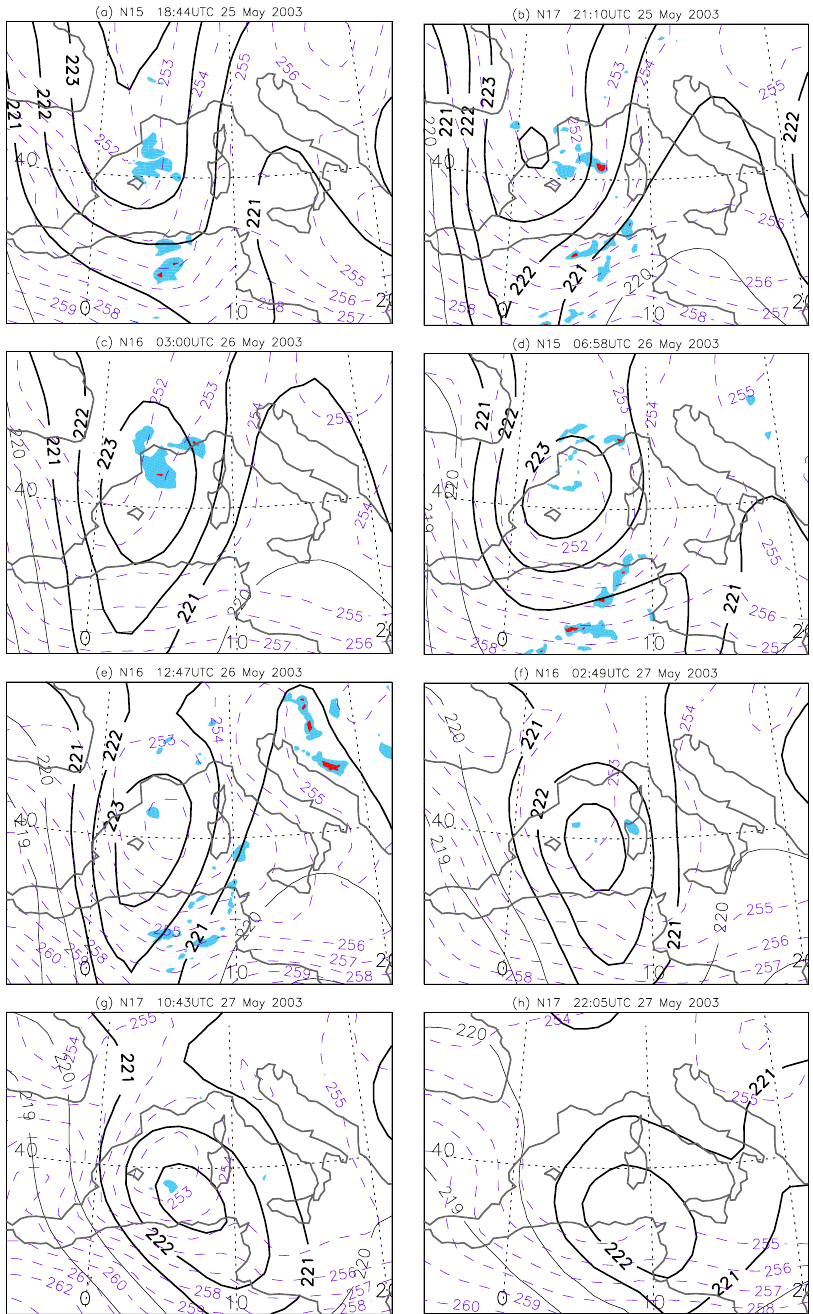
Figure 11 Figure 11 Fig. 11. Same as Fig. 7, but for: (a) NOAA-15, 25 May 2003, 18:44UTC, (b) NOAA-17, 25 May 2003, 21:10UTC, (c) NOAA-16, 26 May 2003, 03:00UTC, (d) NOAA-15, 26 May 2003, 06:58UTC, (e) NOAA-16, 26 May 2003, 12:47UTC, (f) NOAA-16, 27 May 2003, 02:49UTC, (g) NOAA-17, 27 May 2003, 10:43UTC, (h) NOAA-17, 27 May 2003,